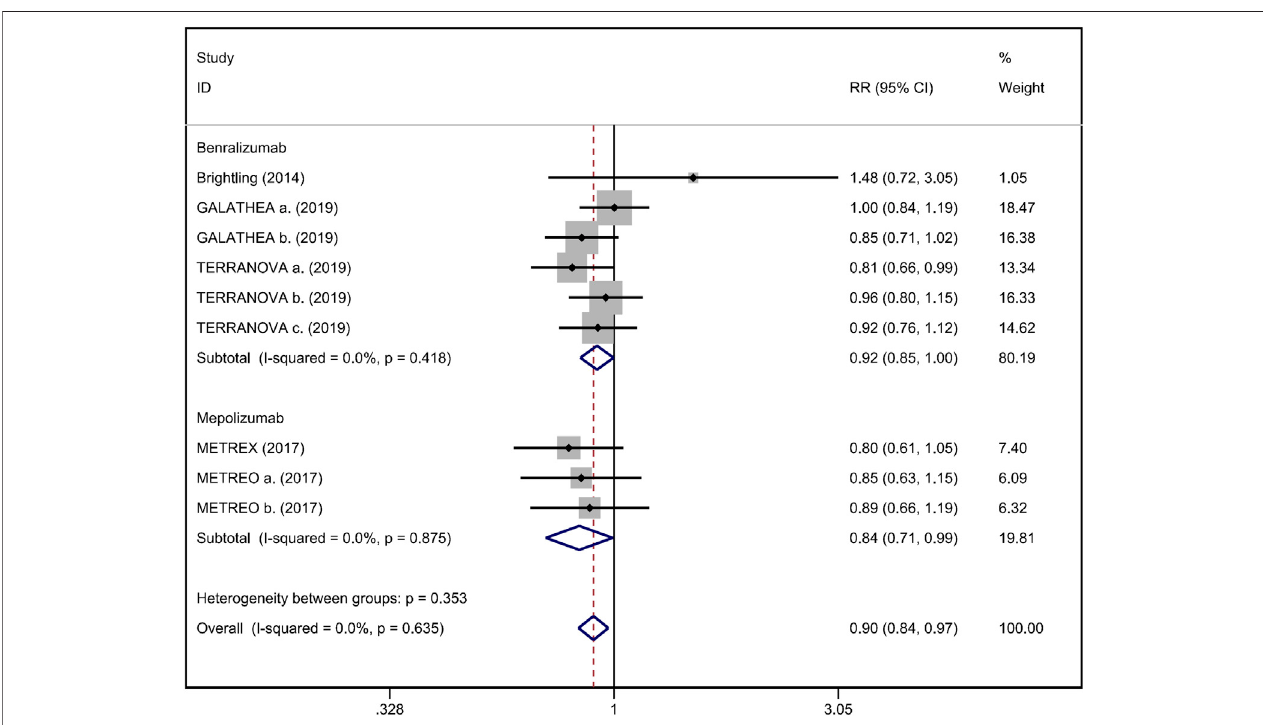
FIGURE 6 | Forest plot of severe adverse event in eosinophilic COPD patients with anti-IL-5 therapy vs. placebo.